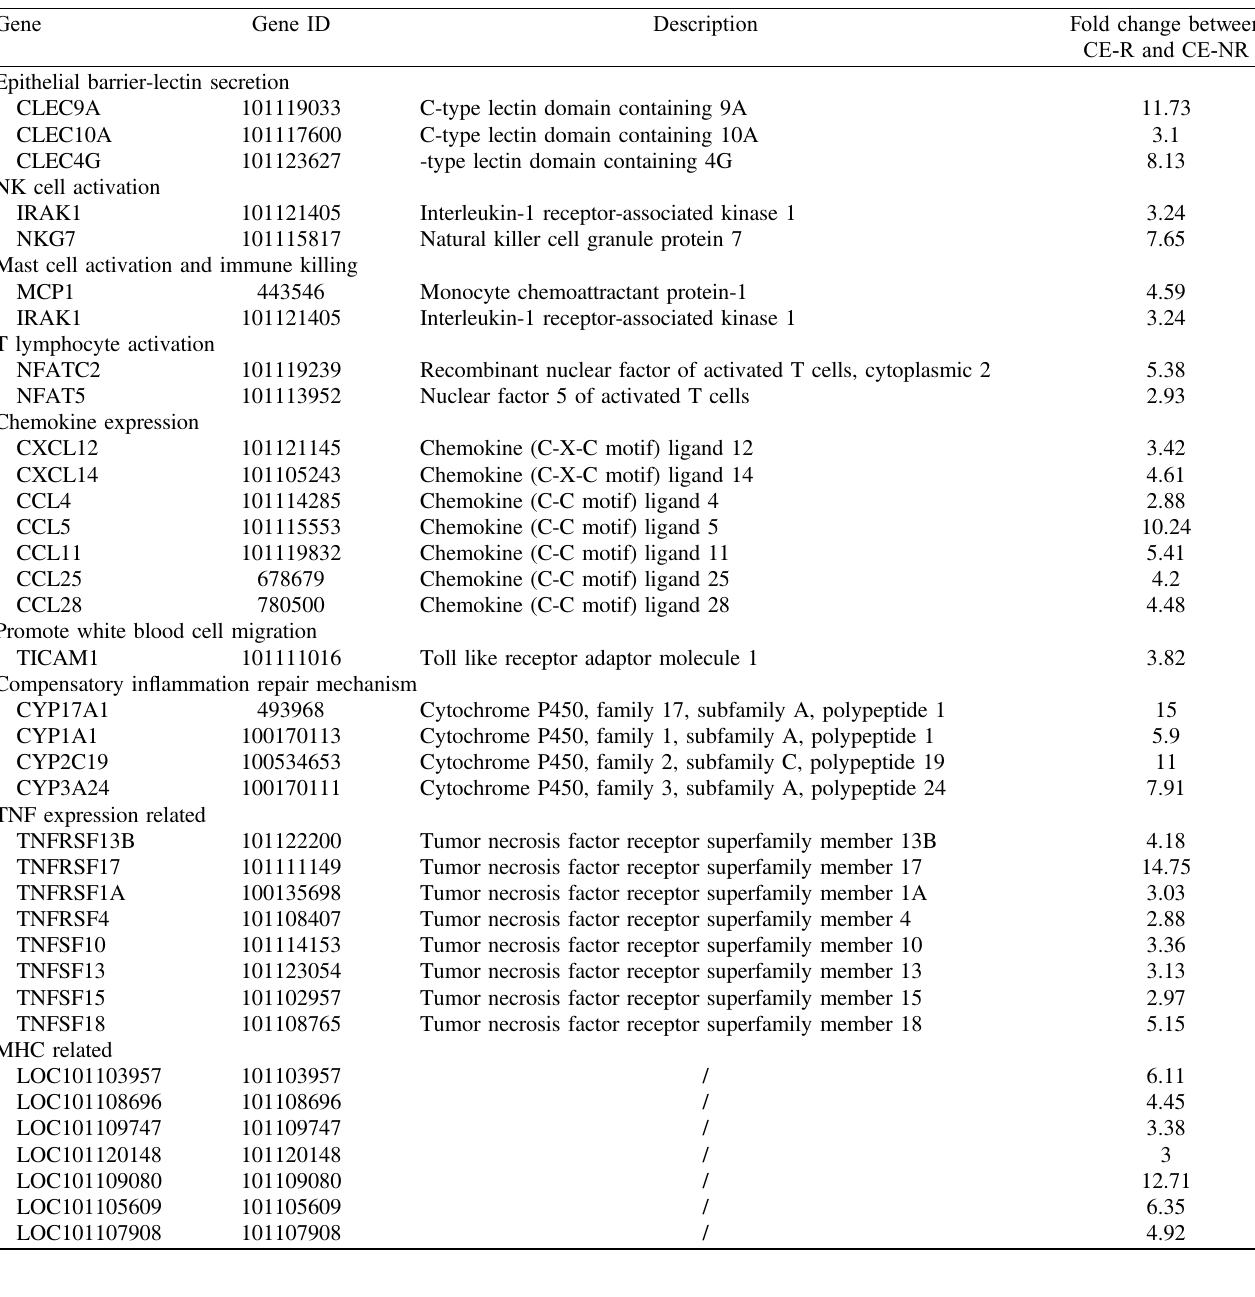
Table 3. Partial differential expression genes in the intestine, organized according to their function group. Gene Gene